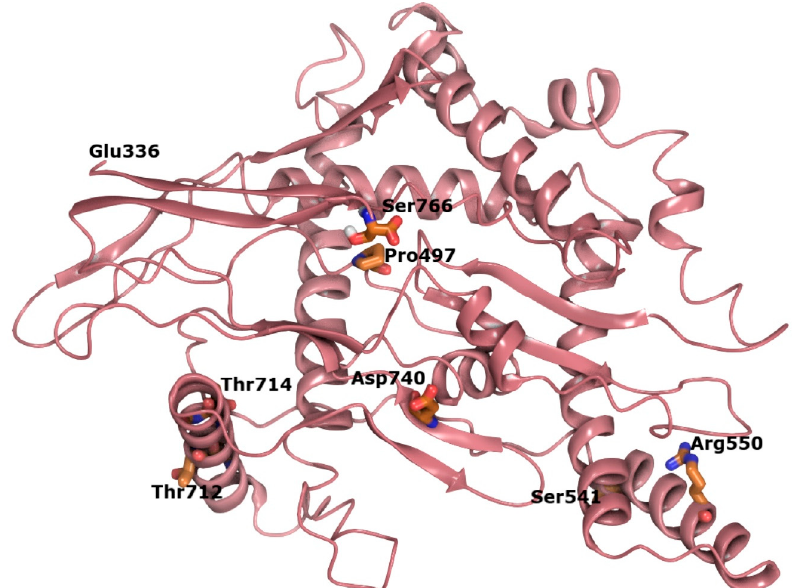
Figure 7. Mapping of all relevant positions in the SM domain (C-term) and their relative position. The SM domain is colored pink in ribbons with key residues in thick licorice rendering for emphasis (carbons-orange, oxygen-red, nitrogen-blue).